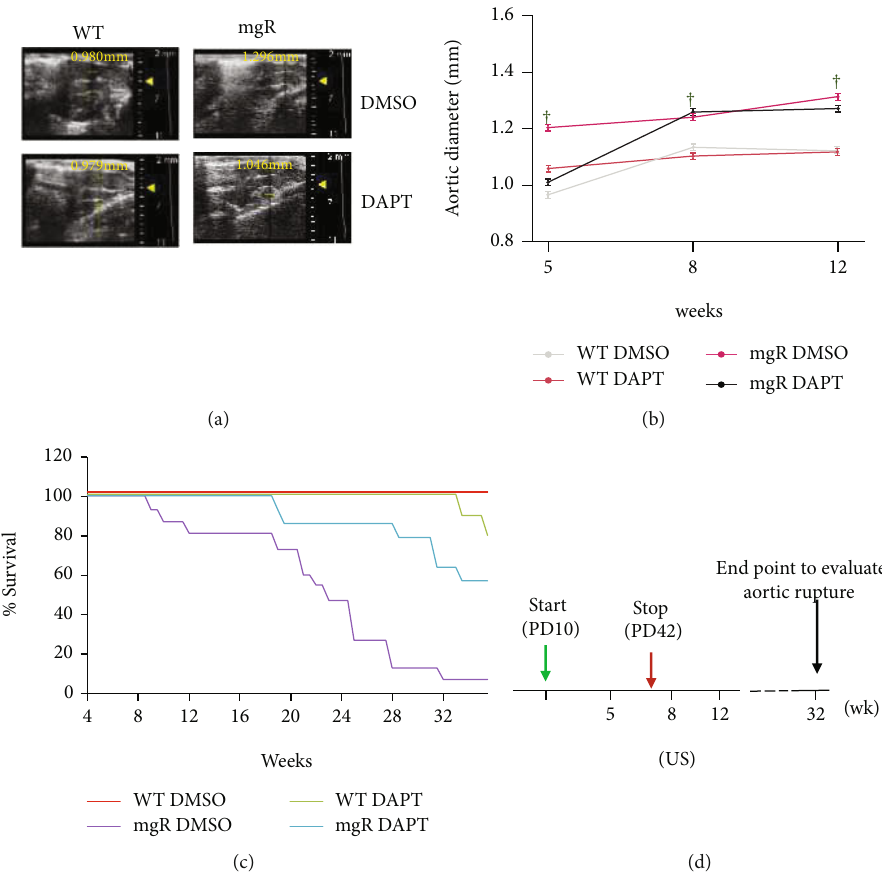
Figure 4: DAPT treatment delayed aortic expansion and improved survival of Fbn1 mgR/mgR (mgR) mice. (a) Timeline of mouse experiments: WT and mgR mice were treated with DAPT (10 mg/kg) or DMSO by subcutaneous injection started at PD10 (start) and stopped at PD42 (stop). (b) Aortic diameters of mgR mice and WT littermates receiving DAPT or DMSO ( n = 10 /group) were measured by ultrasound (US) at 5, 8, and 12 weeks of age. The aortic diameters of DMSO-treated mgR mice were larger compared with WT controls at all time points ( † P < 0 : 01 compared to WT controls). DAPT treatment inhibited aortic dilation of mgR mice at the 5-week time point ( ∗ P < 0 : 01 compared to DMSO-treated mgR mice). (c) Representative ultrasound images of ascending aorta of mice at 5-week time point. (d) Life table analysis of WT ( n = 10 /group) and mgR ( n = 15 /group) mice treated with DAPT or DMSO from PD10 to PD42. Survival rate of mgR mice treated with DAPT was improved compared with DMSO-treated mgR mice ( P < 0 : 01